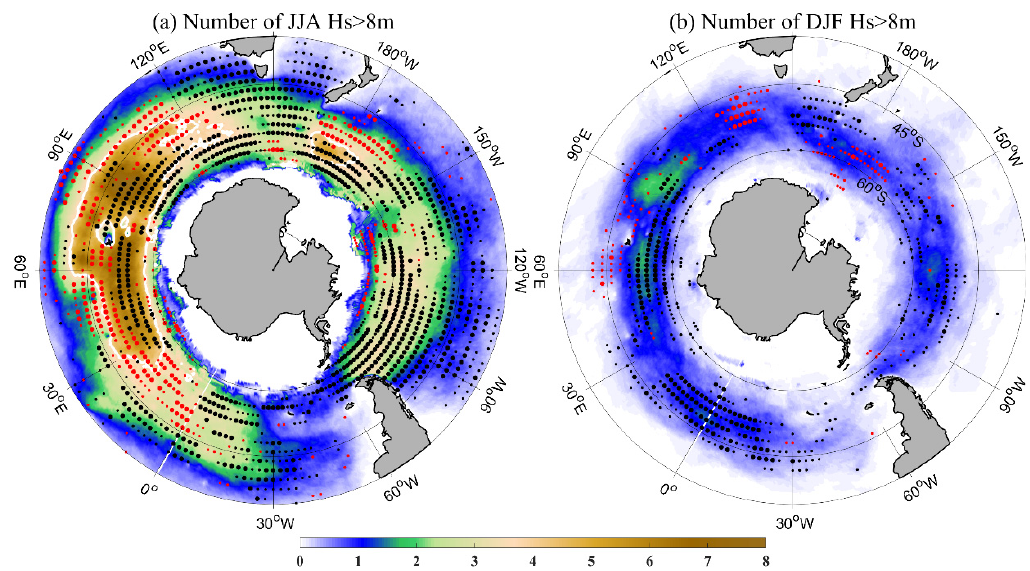
Figure 5. Similar to Figure 2, but for the number of wave processes larger than 8 m. The white contours show the area where the number was more than 4, the small black dots indicate where the trend was higher than 0.01 /a and less than 0.02 /a, the larger black dots show where the trend was larger than 0.02 /a, and the red dots indicate a decreasing trend with the criteria similar to those of the black dots.